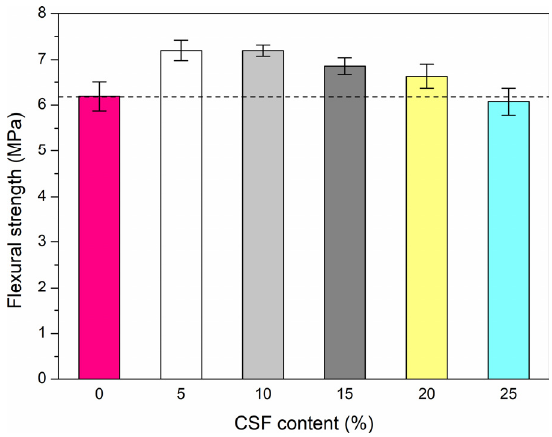
Figure 8. Differences in flexural strength with CSF substitution.